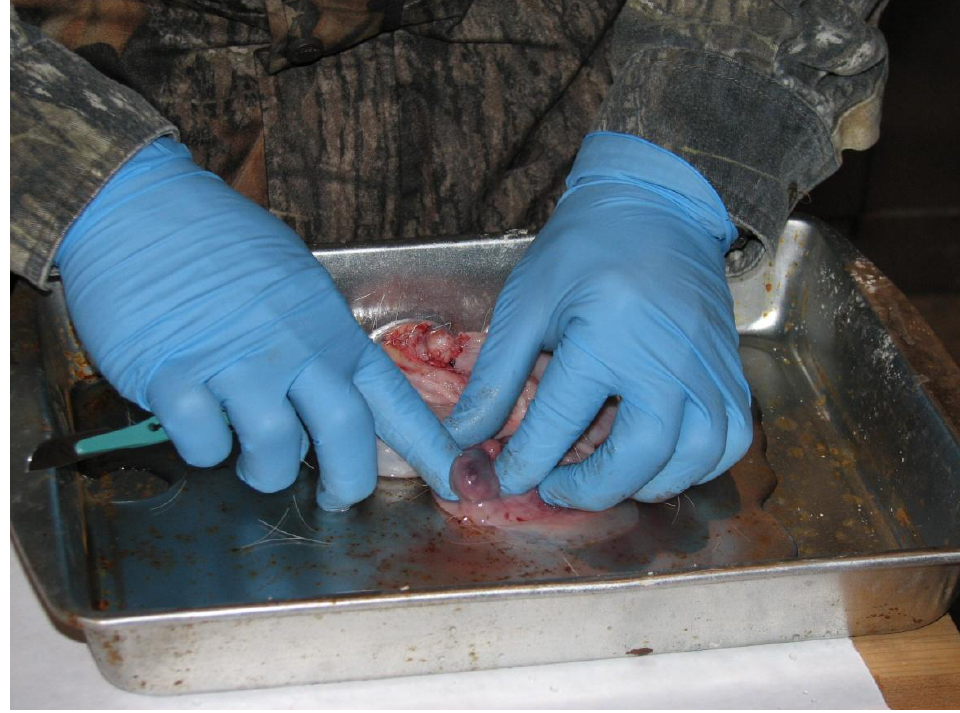
Figure 1 . Counting corpora lutea in ovary from white-tailed deer in Mississippi.